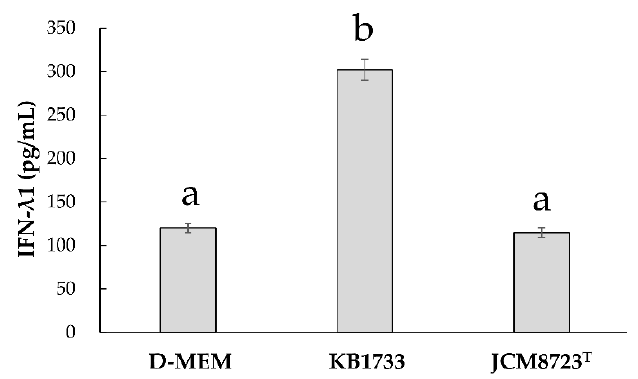
Figure 5. Strain specificity for IFN- λ 1 production after 48 h of KB1733 or JCM8723 T addition ( n = 4). The values are shown as mean ± SE. The treatments are significantly different if they do not share the same letter ( a , b ) ( p- value < 0.05). Data from four independent experiments are shown.